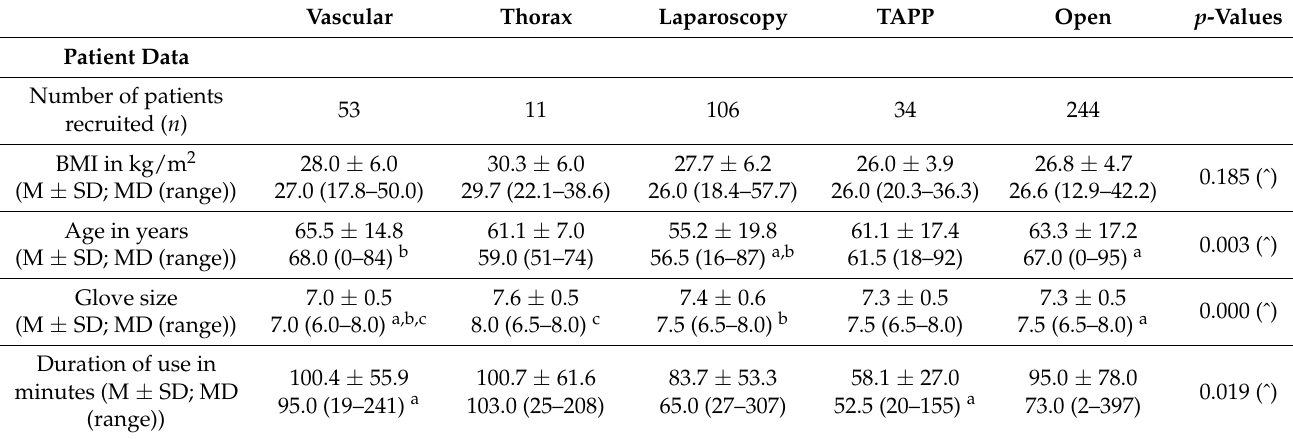
Table 1. Descriptive analysis of surgery and patient data.